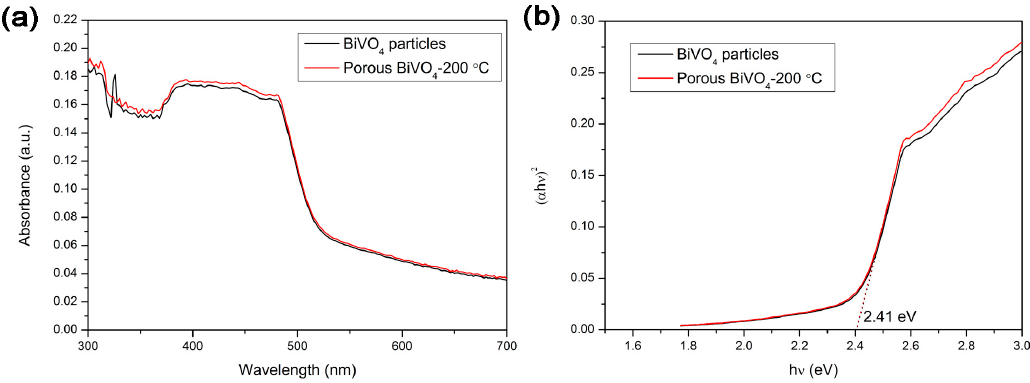
Figure 4. UV–vis diffuse reflection absorption spectra of the sample of BiVO 4 particles as well as the porous BiVO 4 sample prepared at the hydrothermal temperatures of 200 °C ( a ); and the plots of ( α hv ) 2 versus photon energy hv of these two samples ( b ).